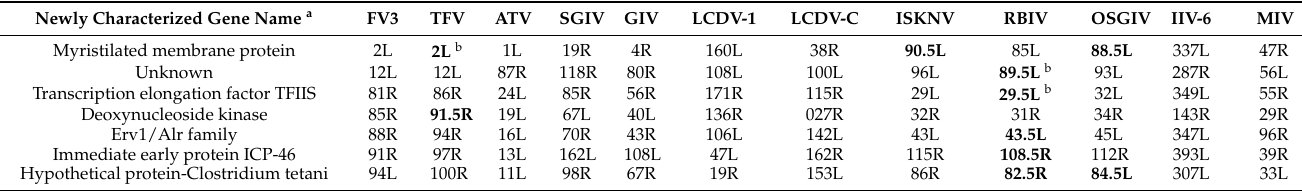
Table 2. Additional Iridoviridae core genes identified after genome